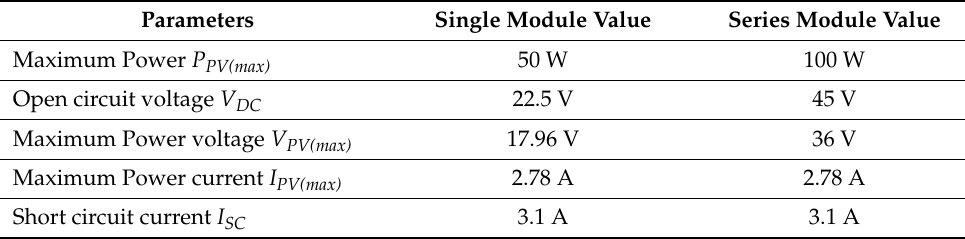
Table 4. Specifications of solar panel.